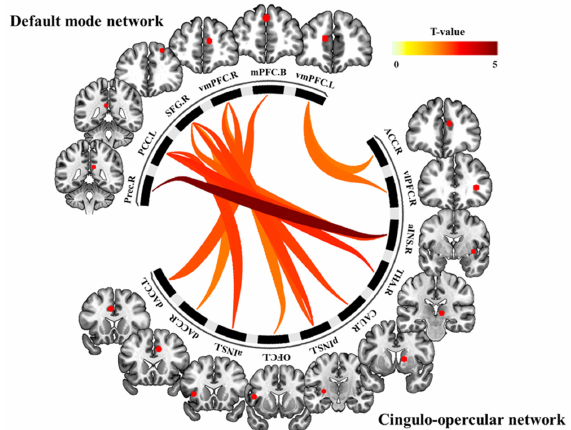
Figure 1. The functional connectivity between cingulo-opercular (CON) and default mode (DMN) showed significant differences between the pre- and post-Comcog conditions in the paired t-test (false discovery rate (FDR) < 0.05 corrected in cluster level). Fourteen positive connections between regions of interest (ROIs) in CON and DMN showed improved connections in the post-Comcog condition. Behav. Sci. 2020 , 10 , x